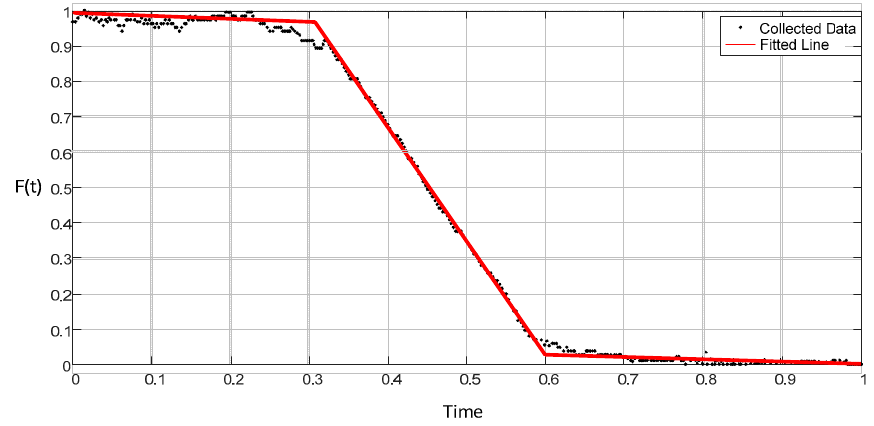
Figure 7. Influence curve. The influence of the ideal trajectory decreases slightly in the first stage and third stage while it falls fast in the second stage.